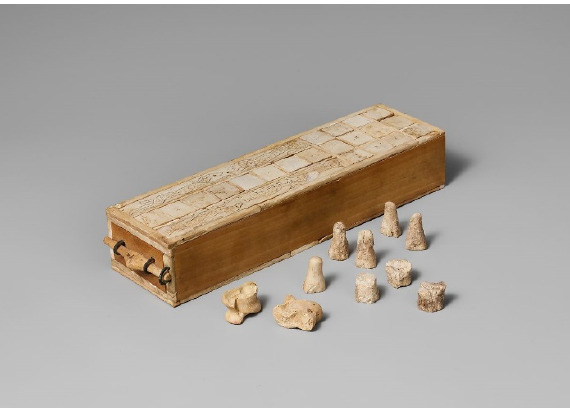
Figure 9. Egyptian game box for playing Twenty Squares from a Late Bronze Age Theban burial (Metropolitan Museum 16.10.475a).